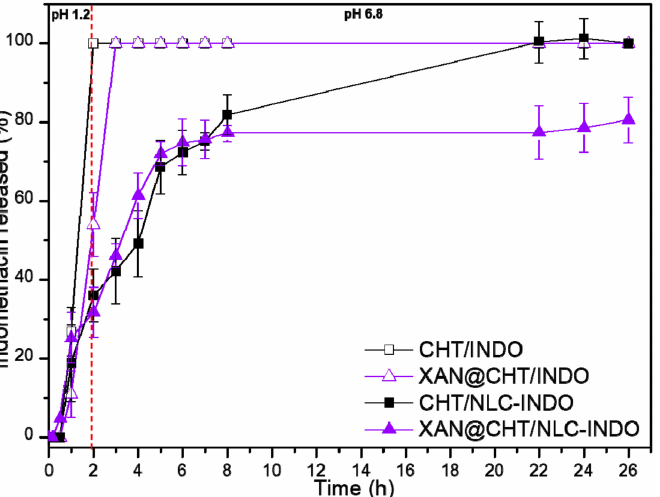
Figure 8. Indomethacin in vitro release from beads (CHT/INDO and XAN@CHT/INDO) and nanobeads (CHT/NLC-INDO and XAN@CHT/NLC-INDO), quantified by UV-vis ( λ = 210 nm) at 37 ◦ C, n = 5.